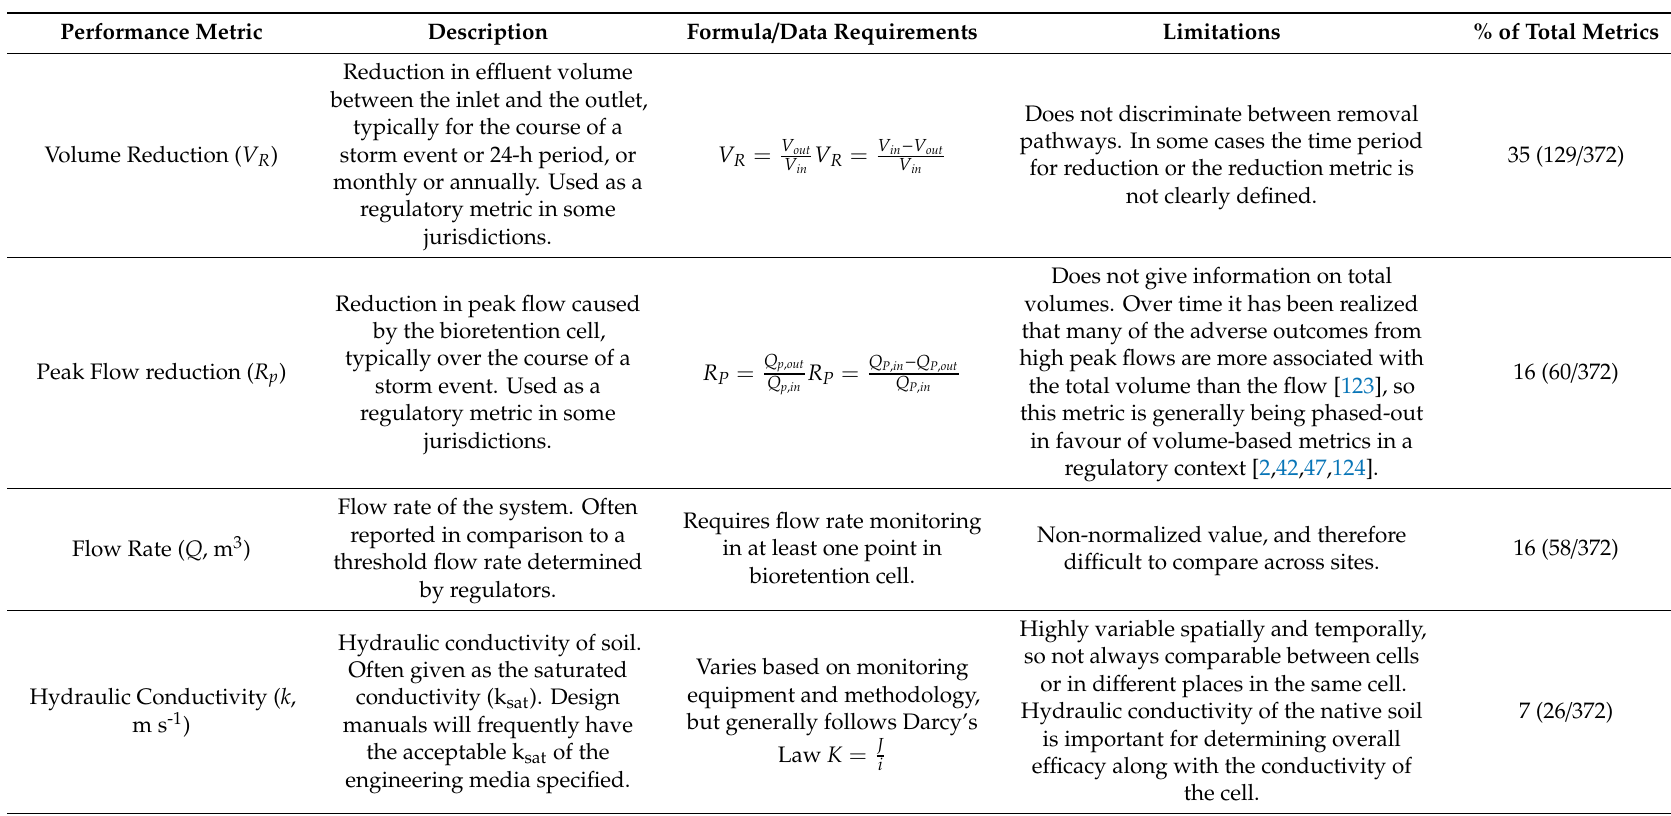
Table 4. Performance metrics used for evaluating hydrologic and contaminant transport and fate performance in bioretention cells. The percentage of total metrics gives the number of times each metric was used divided by the total number of metrics used in all hydrology studies